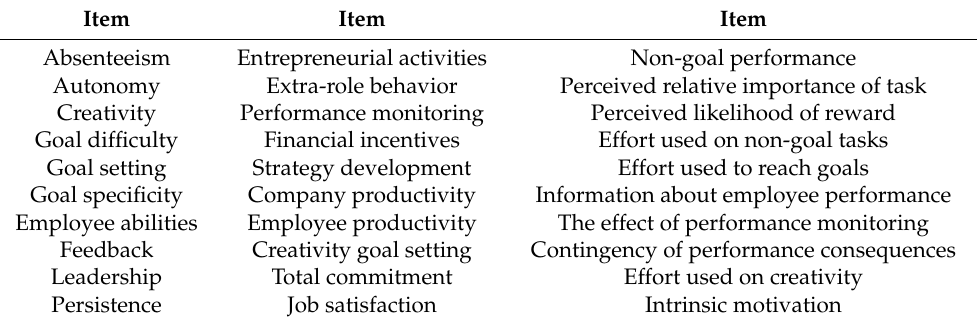
Table 1. Items in on the motivation theme.